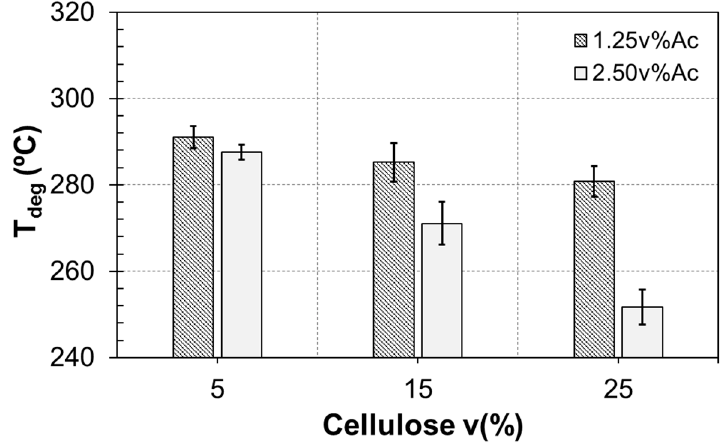
Figure 2. TGA analysis for bio-composites made of 1.5 v% chitosan/0.5 v% cellulose considering 1.25 v% and 2.50 v% of acetic acid.